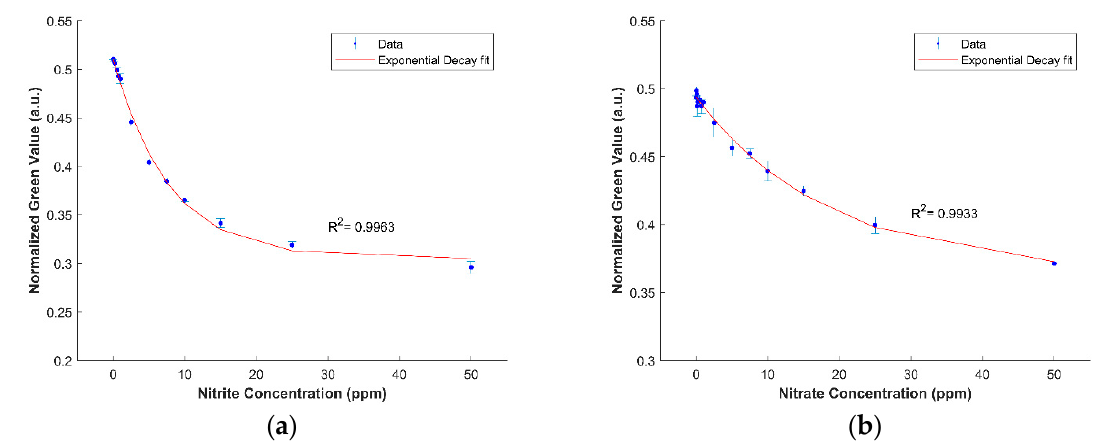
Figure 6. ( a ) An exponential decay calibration curve in the form y = a × exp ( − x/b) + c, where a = 0.2059, b = 7.794, and c = 0.3047 was established for nitrite in deionized water. ( b ) An exponential decay calibration curve in the form y = a × exp ( − x/b) + c, where a = 0.1299, b = 18.65, and c = 0.3638 was established for nitrate in deionized water. The error bars represent the standard deviation.